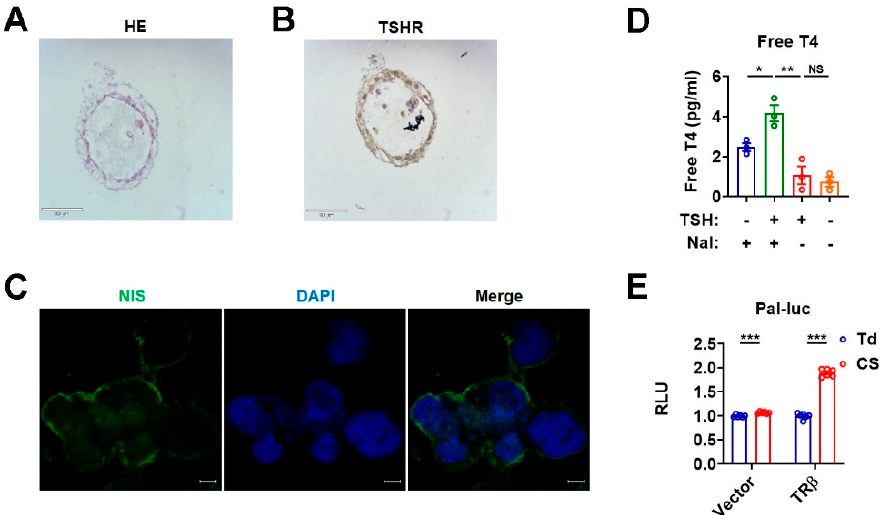
Figure 3. Three-dimensional cultured murine thyroid organoids retain the thyroid function. ( A , B ) Representative images of hematoxylin and eosin (H&E) staining ( A ) and TSHR immunohistochemical staining ( B ) of thyroid organoids. TSHR, thyrotropin receptor. Scale bars: 50 μ m. ( C ) Immunofluorescent staining of NIS in thyroid organoids. NIS (green), nuclear staining with DAPI (blue). Scale bars: 50 μ m. ( D ) The levels of free T4 in the culture supernatants of murine thyroid organoids exposed to NaI (100 nM) with or without hTSH (1 mU/mL) ( n = 3). ( E ) Dual luciferase assay in 293T cells co-transfected with vector or TR β and Pal-luc plasmids, maintained in TH-deficient (Td) medium, or treated with culture supernatants (CS) from the thyroid organoids ( n = 6). Data are presented as mean ± SEM. Statistical significance was determined by Student’s t -test; * p < 0.05, ** p < 0.01, and *** p < 0.001. NS, not significant.